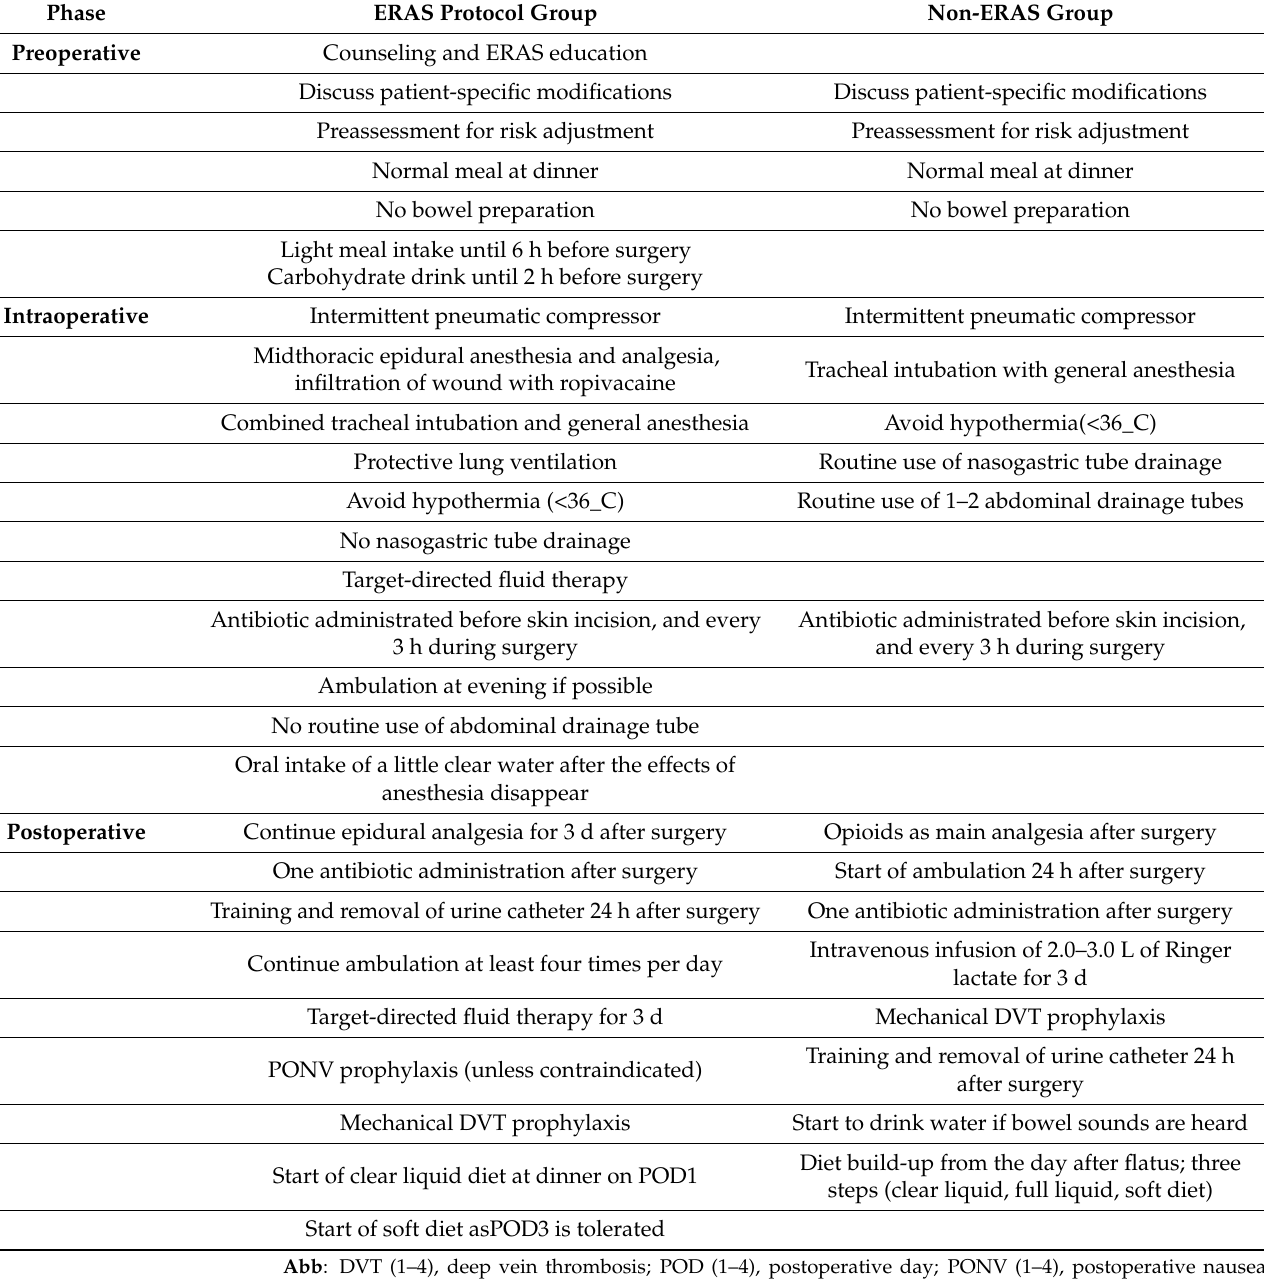
Table 1. Perioperative protocols in the ERAS and